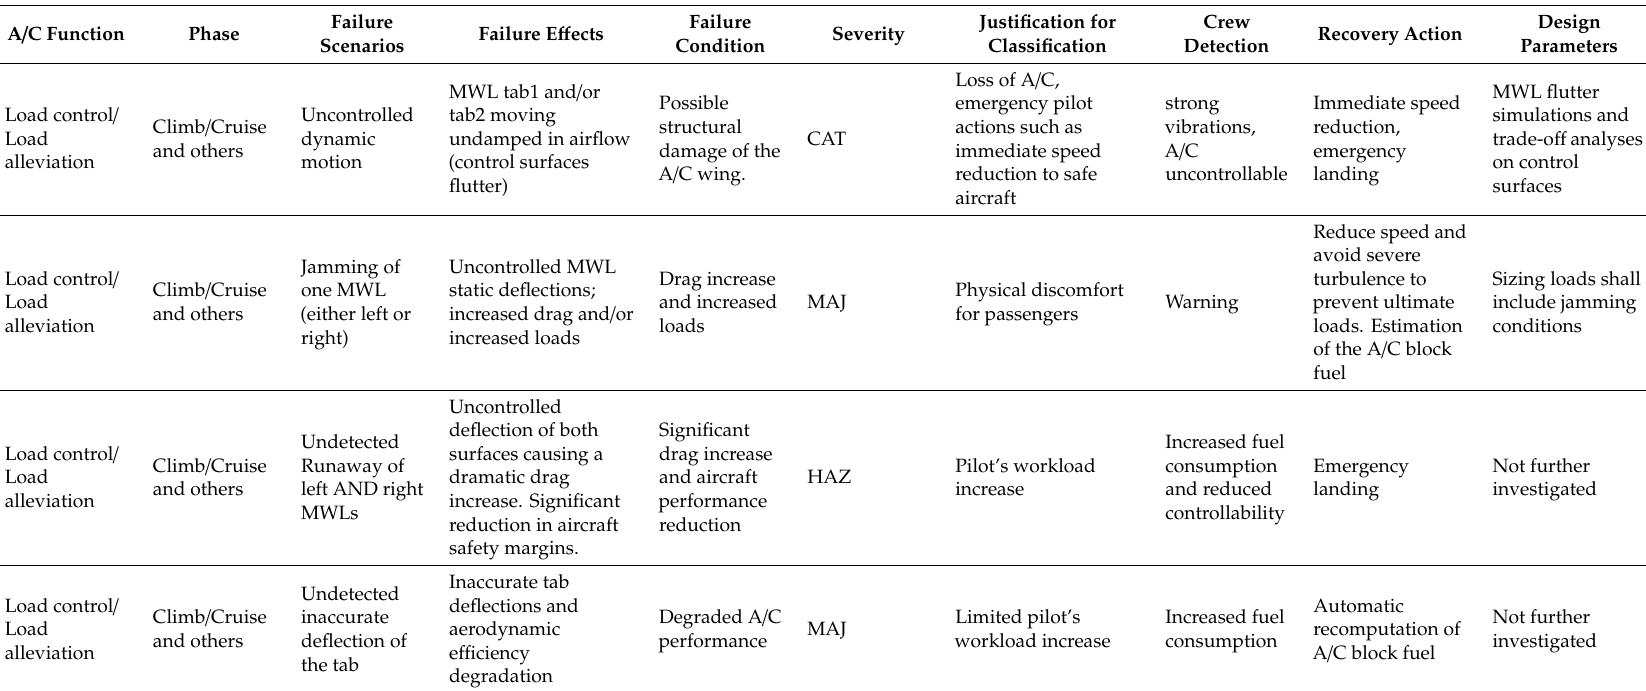
Table 3. Morphing winglet FHA. Catastrophic (CAT), Major (MAJ), Hazardous (HAZ)